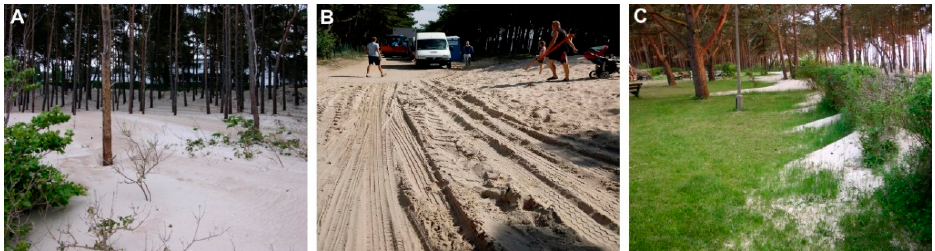
Figure 3. Examples of the effects of aeolian processes: ( A ) sand-covered forest, ( B ) sand-covered road, ( C ) shadows and sand cover in a holiday resort.